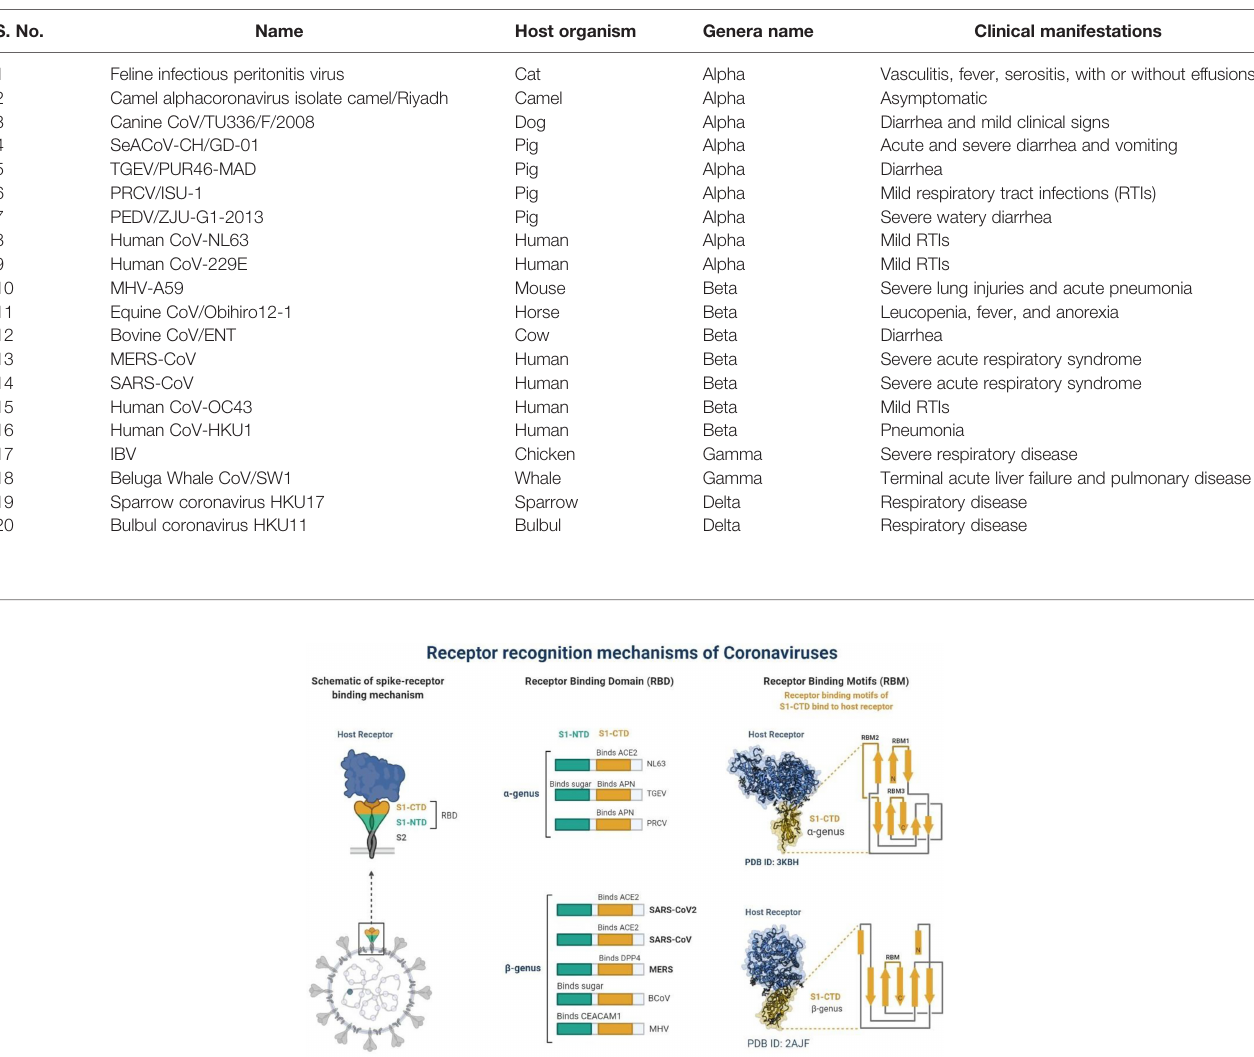
TABLE 1 | List of important pathogenic coronaviruses their host organisms, genera name, and associated clinical manifestations. S.